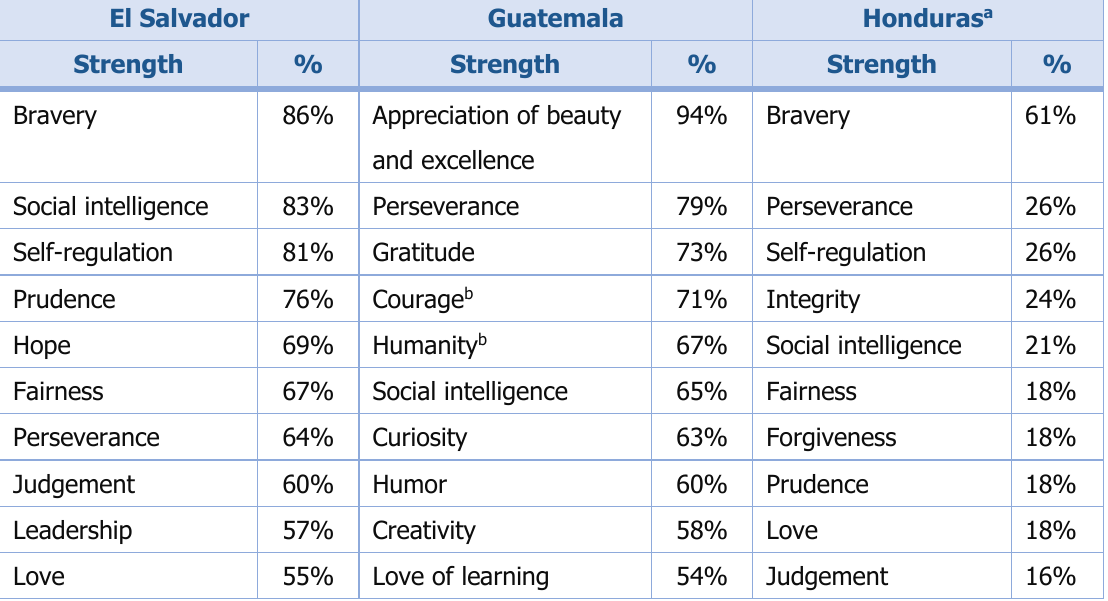
Table 1. Distribution of the Top 10 Character Strengths Prioritized by Participants in Consultation Process by